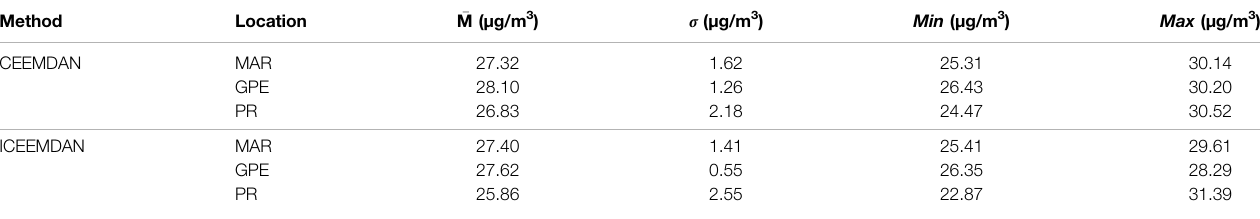
TABLE 2 | Statistical parameters (Mean ( (cid:2) M ) , Standard deviation ( σ ), Minimum ( Min ), Maximum ( Max )) of PM 10 residual at Martinique (MAR), Guadeloupe (GPE) and Puerto- Rico (PR) over 6 years with CEEMDAN and ICEEMDAN methods. For each island the data point number N is 2,190.